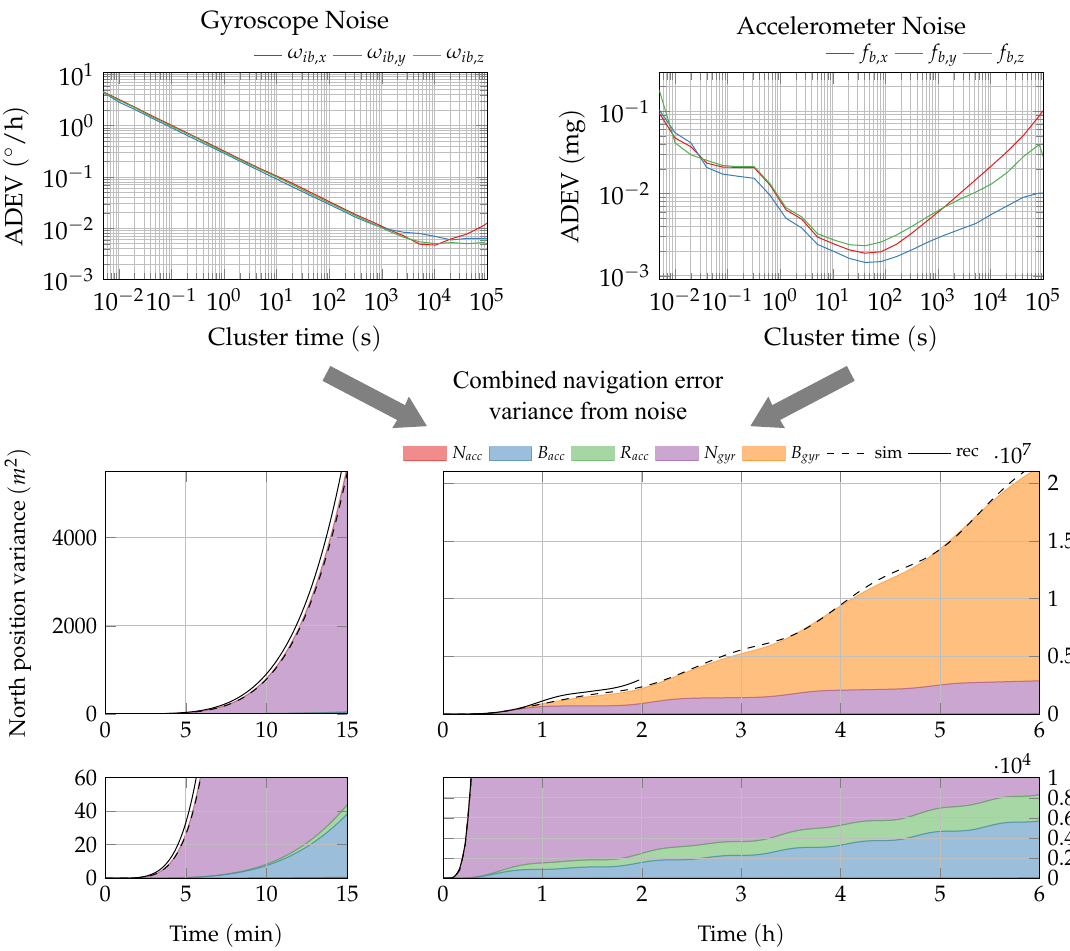
Figure 11. Composition of the north position variance for example noise processes identified from a Fiber Optic Gyroscope compared to the resulting variance from 10,000 Monte Carlo runs with numerically simulated synthetic IMU noise (labeled sim, dashed line) and 24 runs using the real recorded IMU noise (labeled rec, solid